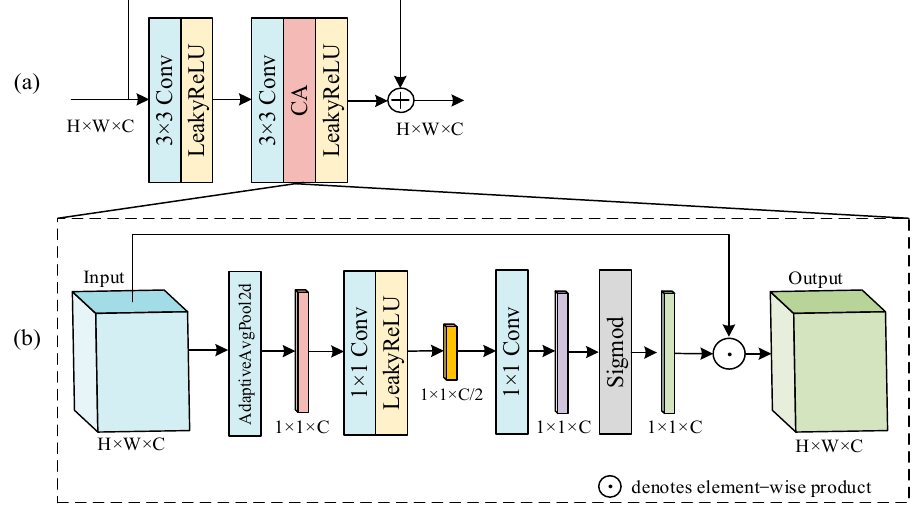
Figure 4. The illustration of the RCA. ( a ) Details of RCA module; ( b ) details of CA sub-module.